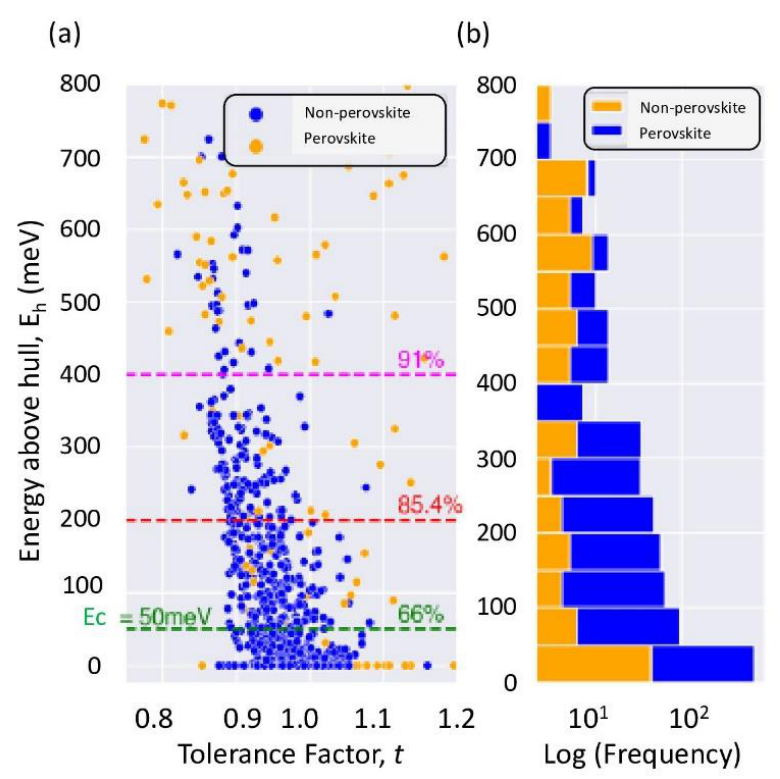
Figure 6. ( a , b ) Energy above hull ( ∆ E h ) in meV as a function of tolerance factor ( t ) for candidate materials identified as stable and formable. Reproduced with permission from Ref. [29].